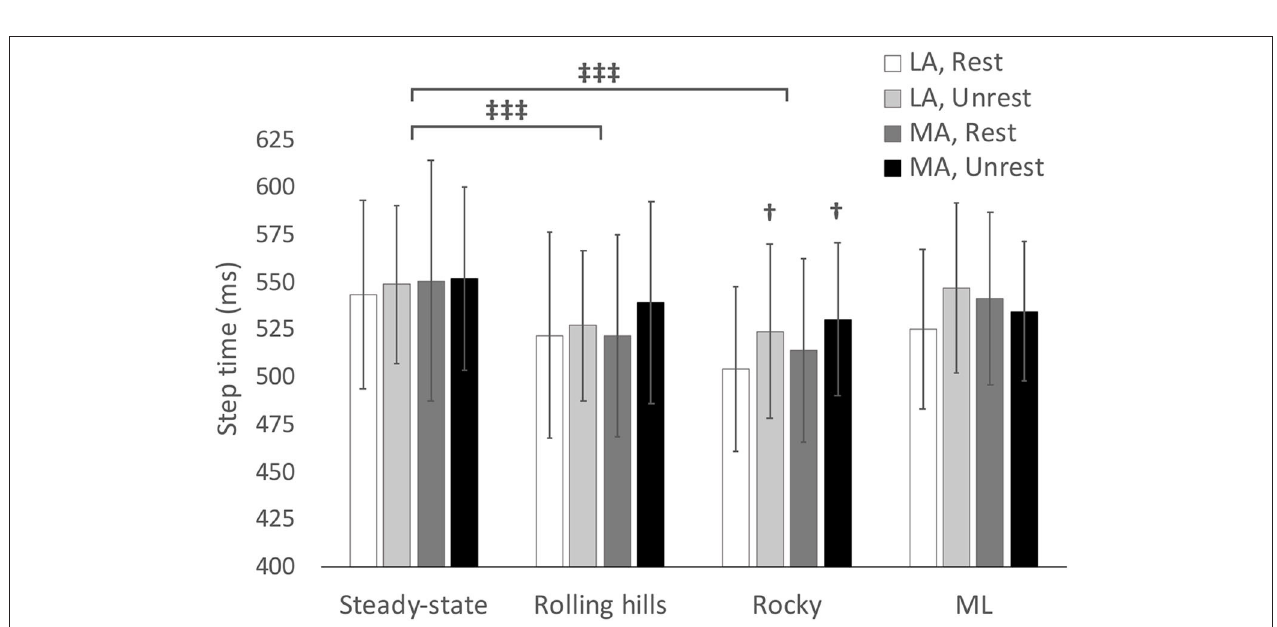
FIGURE 1 | Average step length with respect to terrain conditions for most (MA) and least affected (LA) leg in both restricted and unrestricted arm swing conditions. † represents a significantly larger value in the unrestricted arm swing condition than restricted within the same leg and terrain condition p < 0.05. *represents a significantly larger value in LA than MA within the same terrain at p < 0.05.